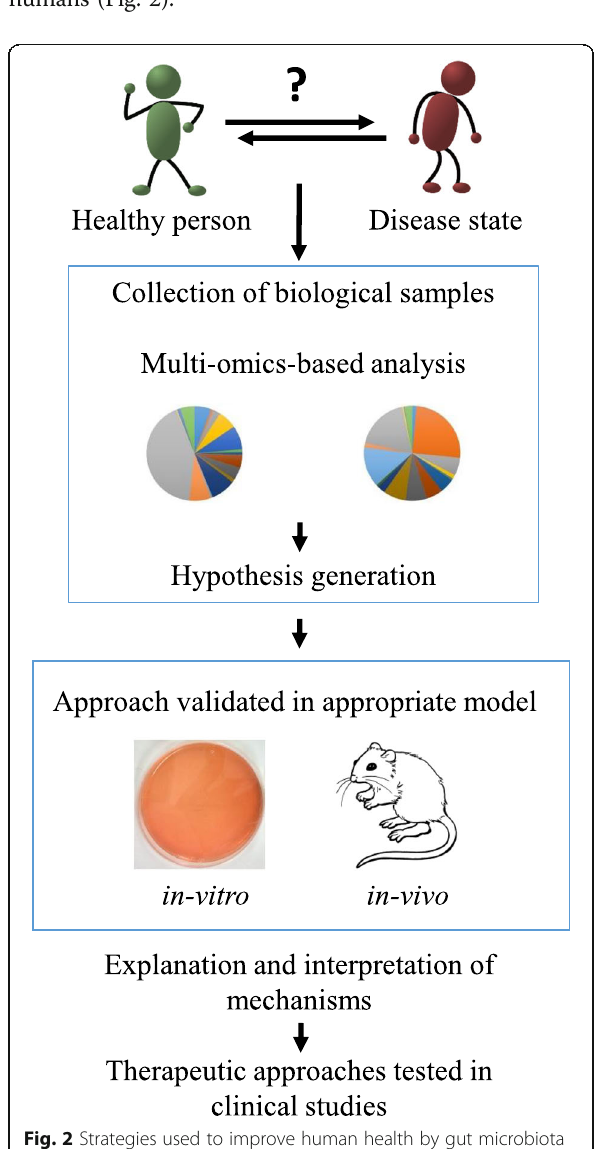
Fig. 2 Strategies used to improve human health by gut microbiota modulation. Multi-omic approaches are employed to increase the understanding of how the microbiota may affect human